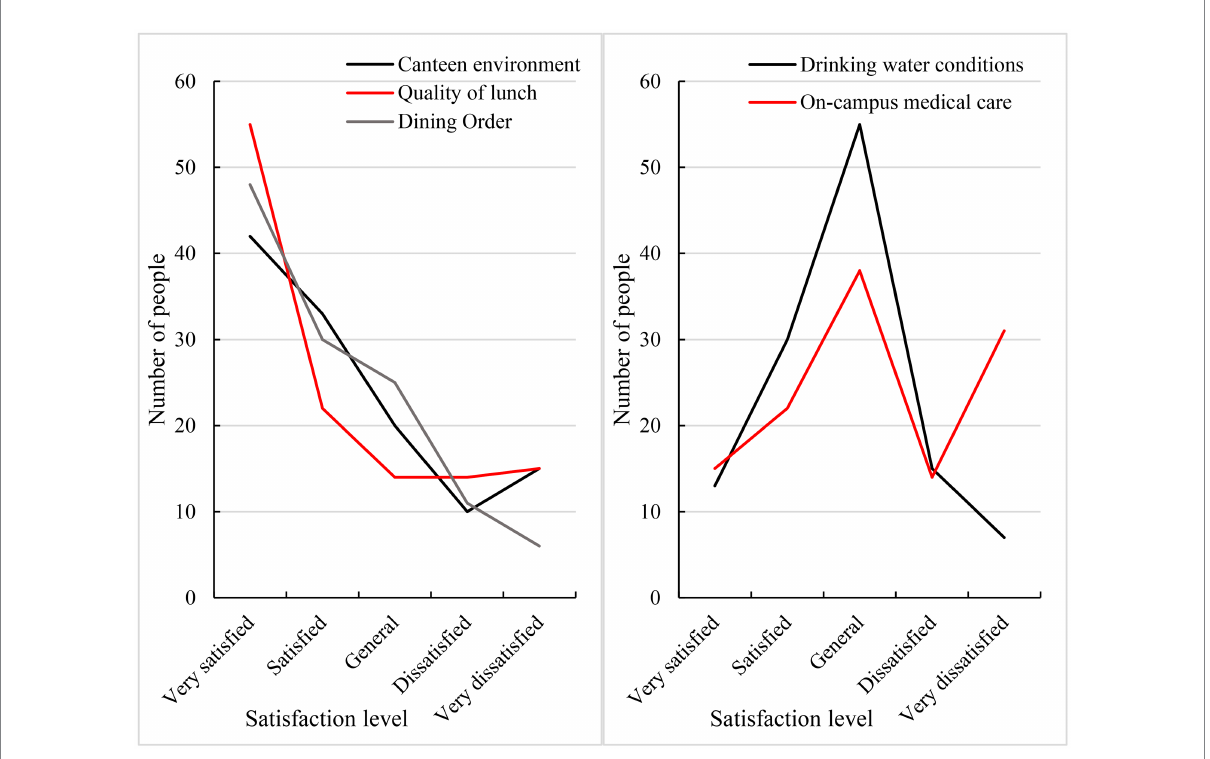
FIGURE 6 Survey results concerning overseas students’ satisfaction with dietary conditions, drinking water conditions, and on-campus medical